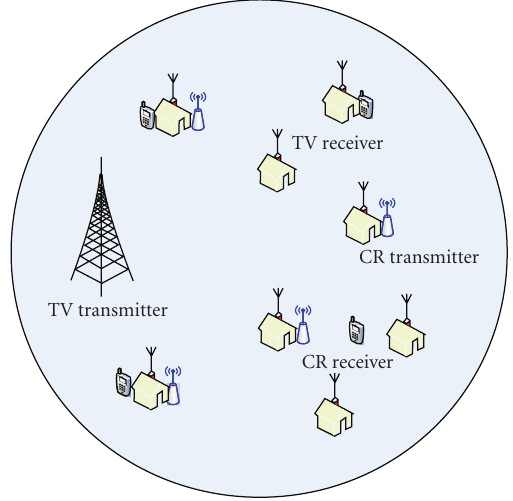
Figure 2: In future commercial applications the aggregate power levels of cognitive devices need to be controlled in order to avoid interference to primary